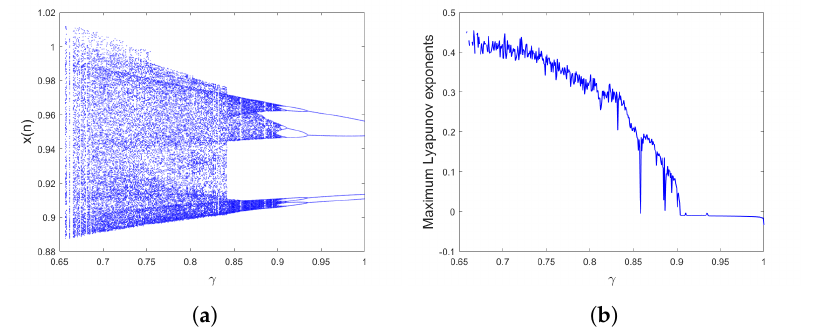
Figure 1. ( a ) Bifurcation of (3) versus γ for a = 2.5, b = 5, c = 5.5, δ = 1.05, ( b ) The correspond- ing MLE.